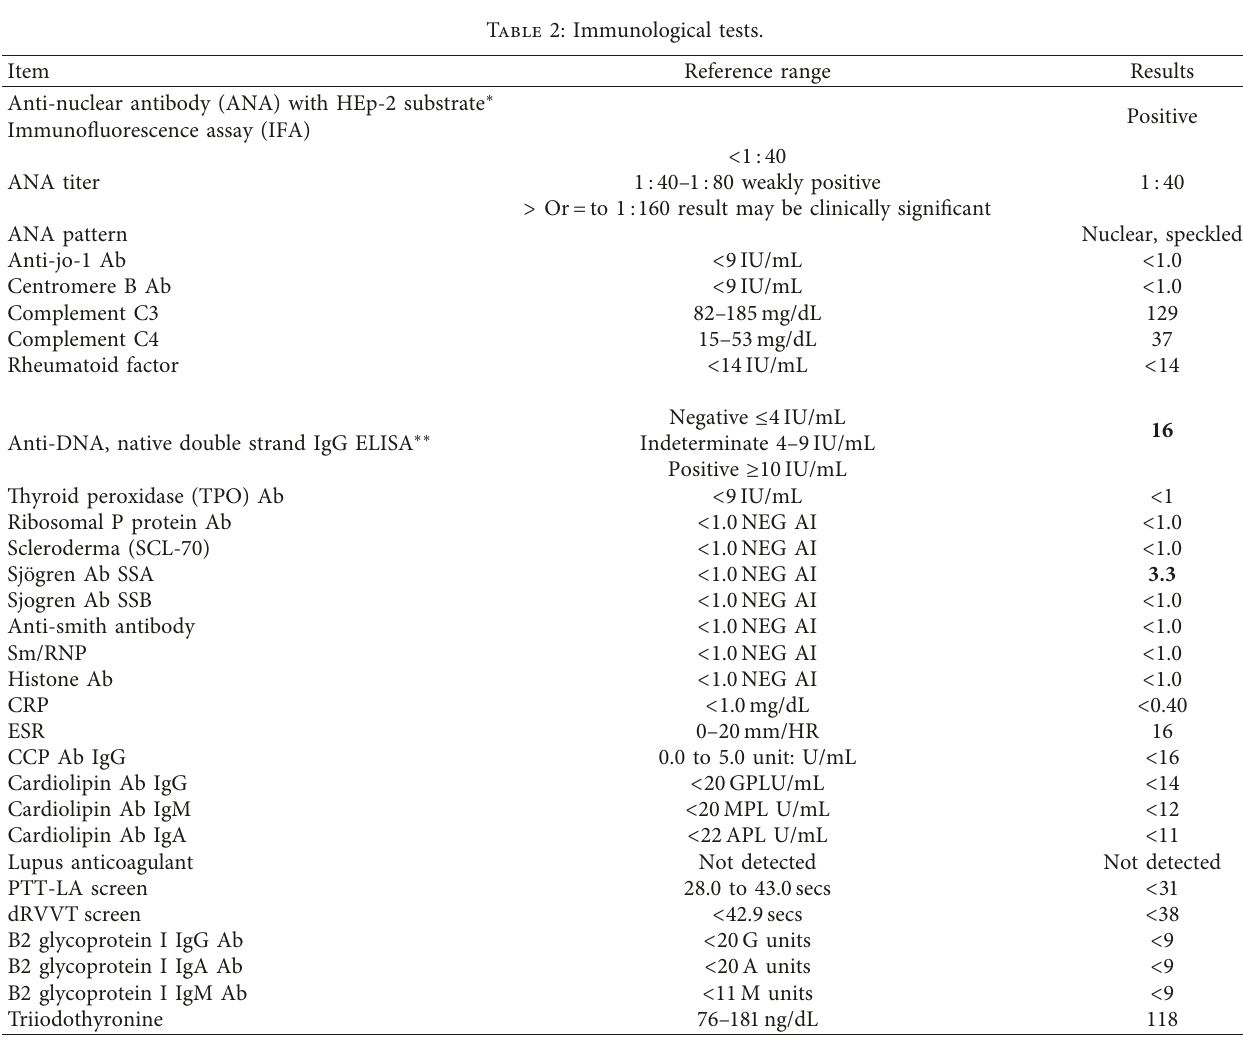
Table 2: Immunological